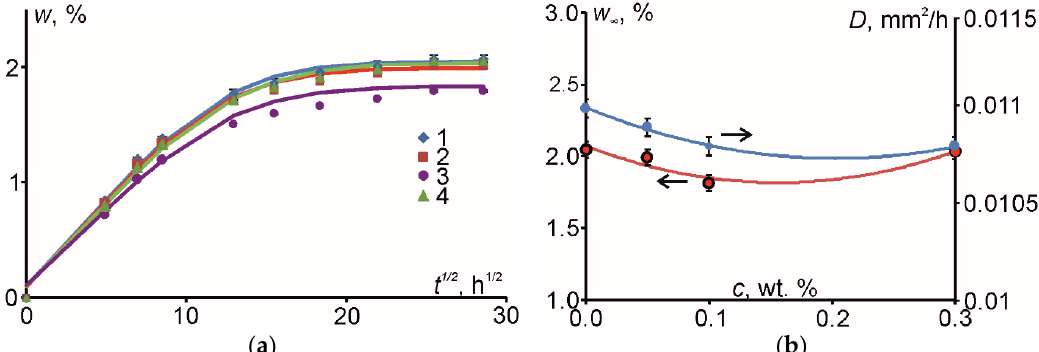
Figure 5. ( a ) Kinetics of water sorption of the epoxy ( 1 ) and epoxy filled with 0.05 wt. % of CNT ( 2 ), 0.1 wt. % of HN ( 3 ), and 0.3 wt. % of CNF ( 4 ) (dots-experimental data, lines-evaluation by Equation (20); ( b ) diffusion coefficient and equilibrium moisture content as function of nanofiller’s (-s’) weight content (dots-experimental data, lines-polynomial approximations).